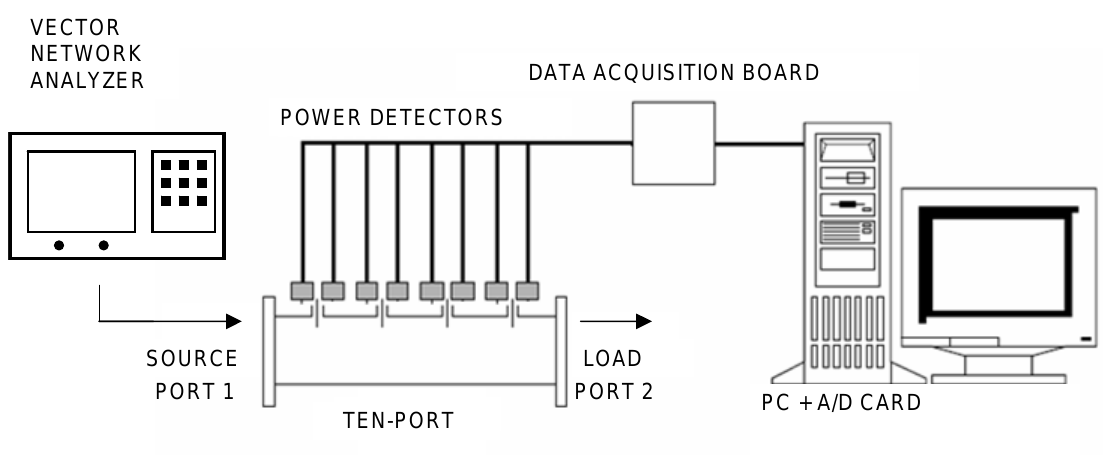
Figure 3. Experimental set